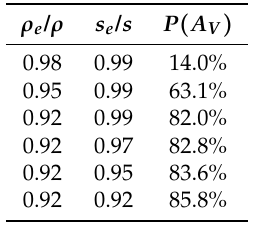
Table 2. Experimental probability for different values of ρ e and s e